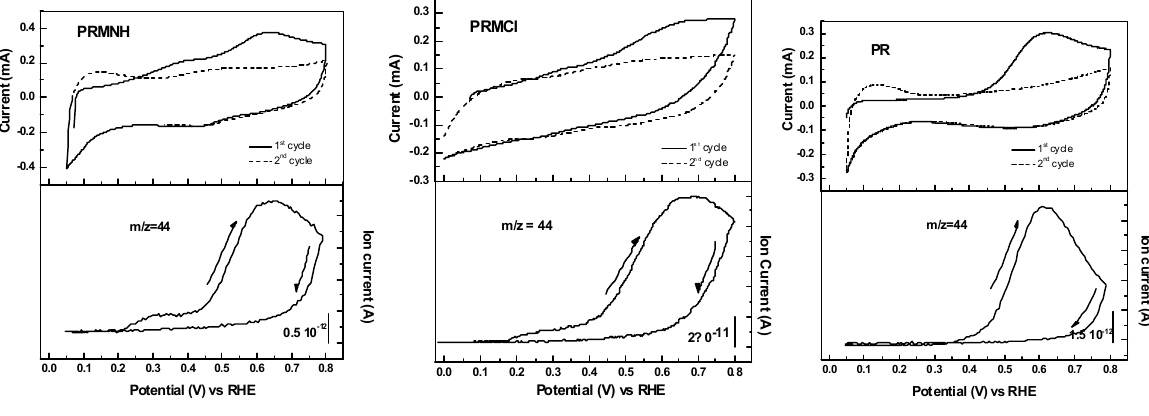
Figure 5. CV for the oxidation of CO in 0.5 M H corresponding signal for CO Tsiouvaras et al.